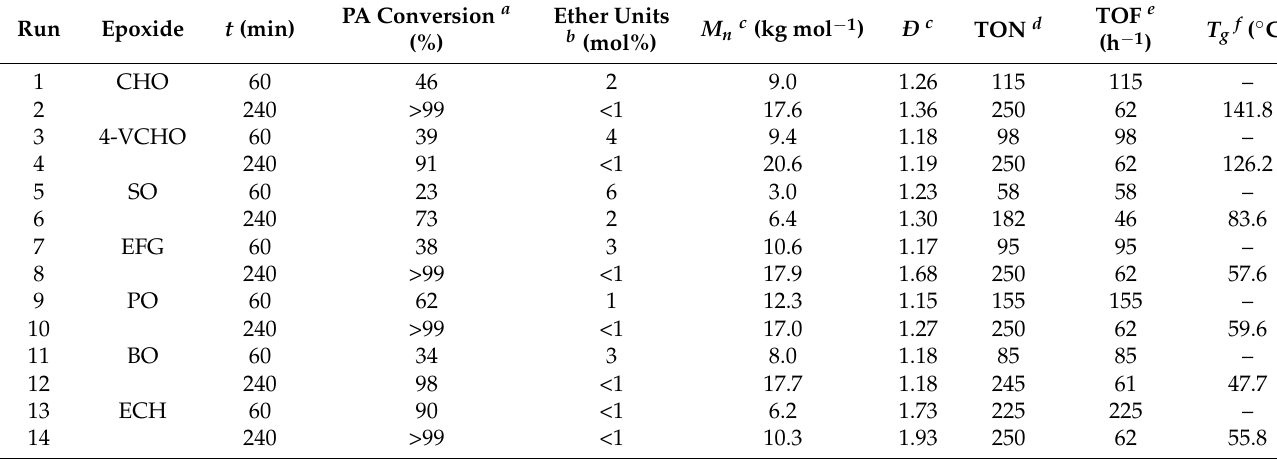
per mole of catalyst. e TOF = TON per hour. f Determined by DSC from 2 nd heating at a heating rate of 10 ◦ C min − 1